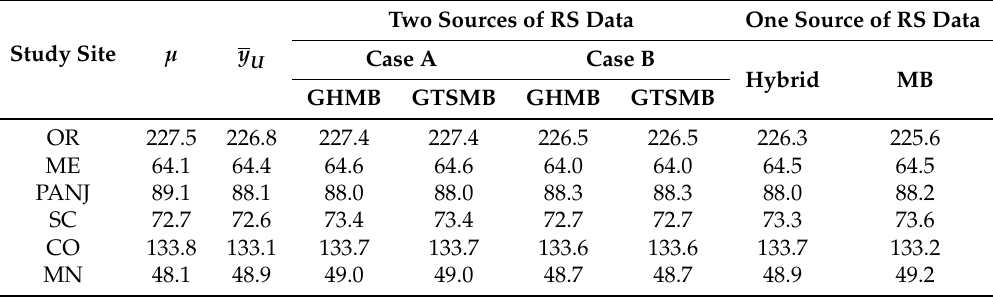
Table 7. Estimated expected value of population mean, (cid:98) µ ,